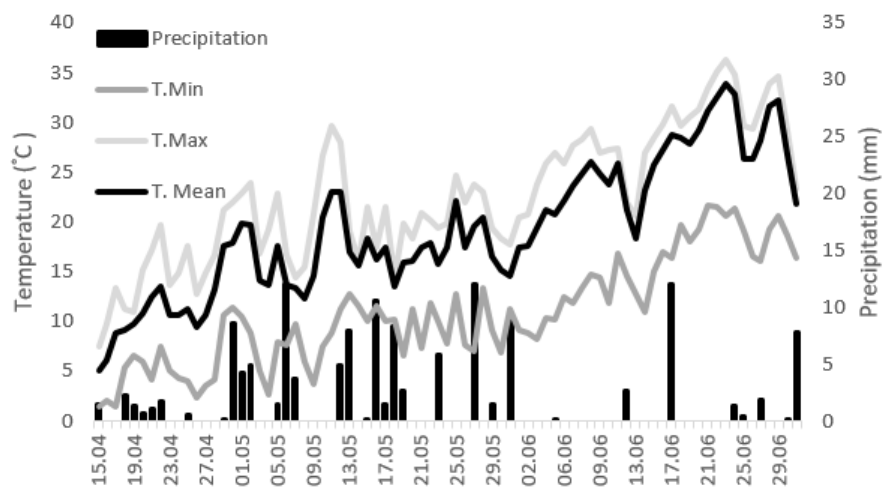
Figure 8. Temperature changes and precipitation in the experimental area from 15 April 2021 to the 2 weeks following the last sampling. The data originate from the Institute of Plant Protection, University of Debrecen’s meteorological station (47°33 ′ 07.7 ′ ’ N 21°36 ′ 00.3 ′ ’ E).